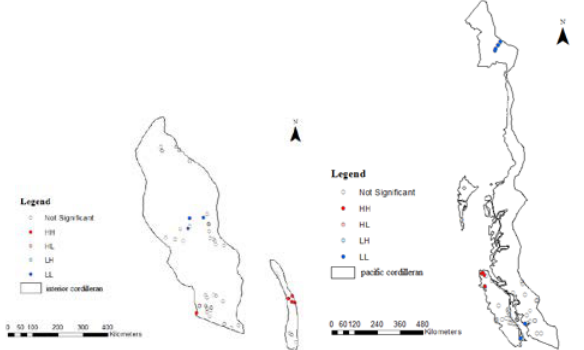
Figure 12. LISA maps of SOC levels in Interior Cordilleran eco-region (left) and Pacific Cordilleran eco-region (right)